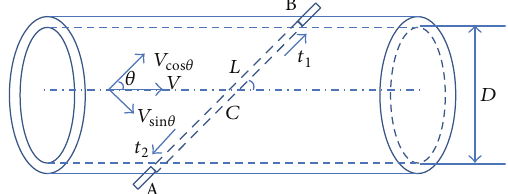
Figure 1: The diagram of the principle of ultrasonic flowmeter.